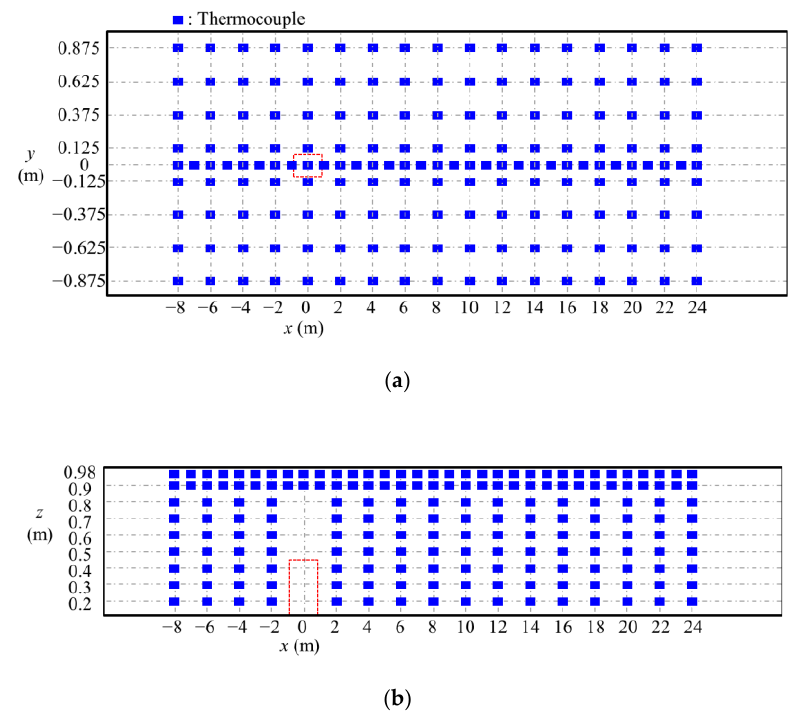
Figure 5. Configuration diagram of the thermocouples: ( a ) Thermocouples on the ceiling ( z = 0.98 m); ( b ) Thermocouples on the wall in the vertical direction ( y = 0).